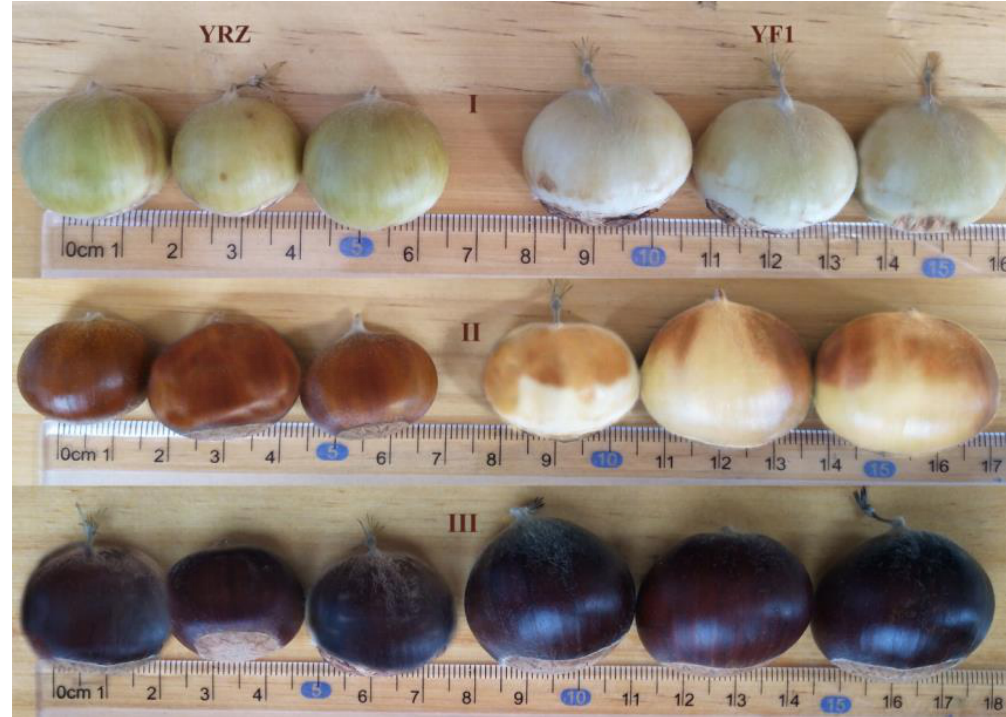
Figure 1. Illustration of seeds at three stages that were included in the study. I: 70 DAF, II: 82 DAF, III: 94 DAF. YF1, “Yongfeng 1” cultivar; YRZ, “Yongren Zao” cultivar.